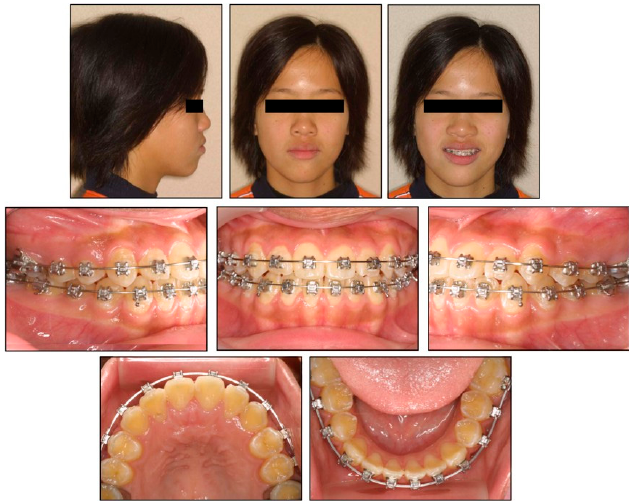
Figure 4. Case 1, Facial and intraoral photographs after 10 months of treatment.